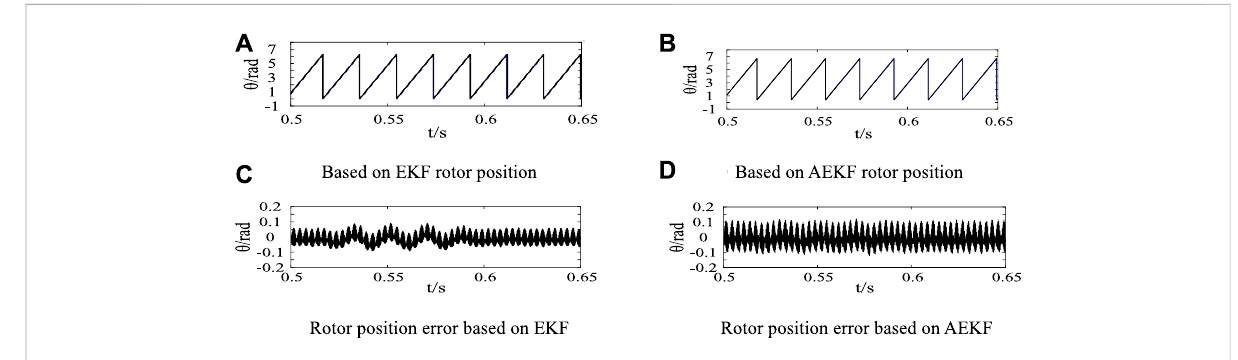
FIGURE 5 Comparison of rotor position under external interference. (A) Based on EKF rotor position. (B) Based on AEKF rotor position. (C) Rotor position error based on EKF. (D) Rotor position error based on AEKF.